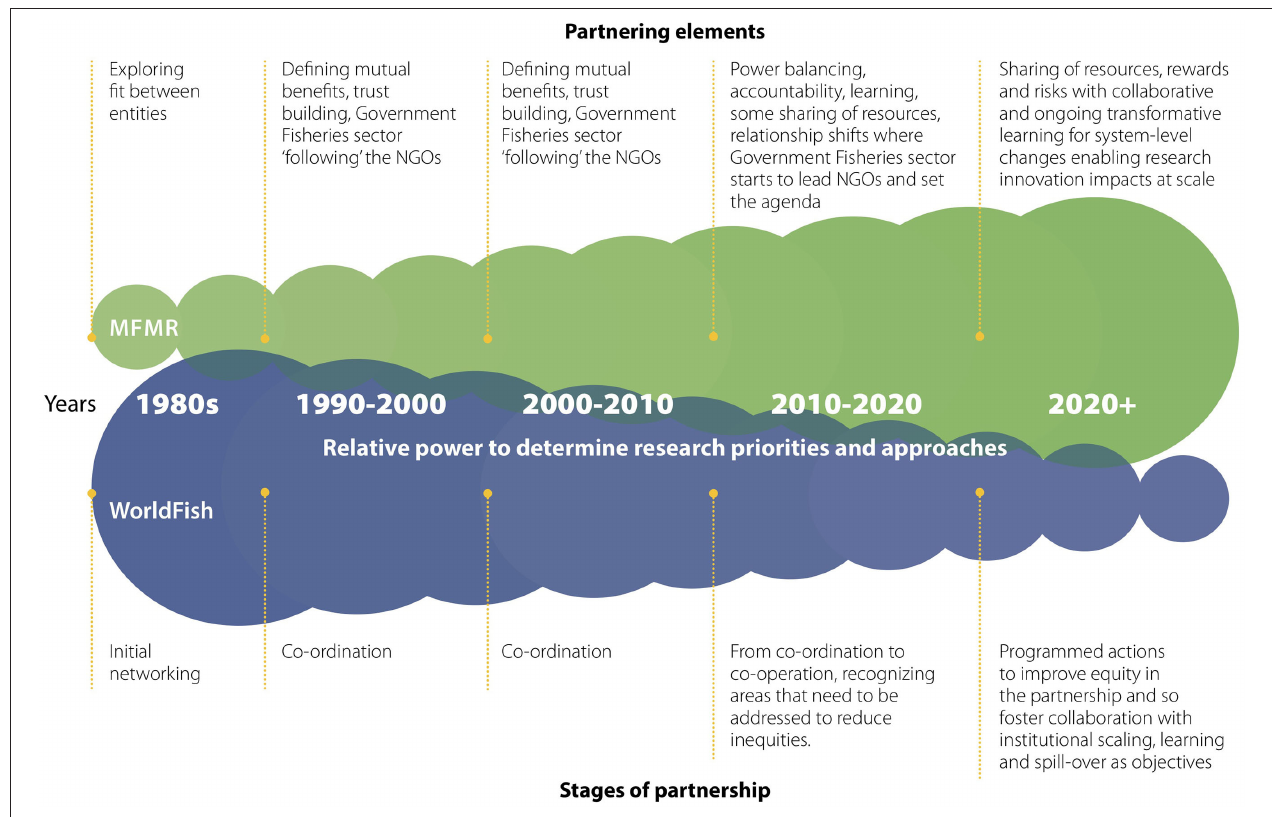
FIGURE 2 | The differences in relative participation, collaboration and power between MFMR and WorldFish to determine and direct research for development needs over time, mapped to the stages of a research-development partnership, adapted from Prain et al. (2020), and including themes of equity described by Price et al.